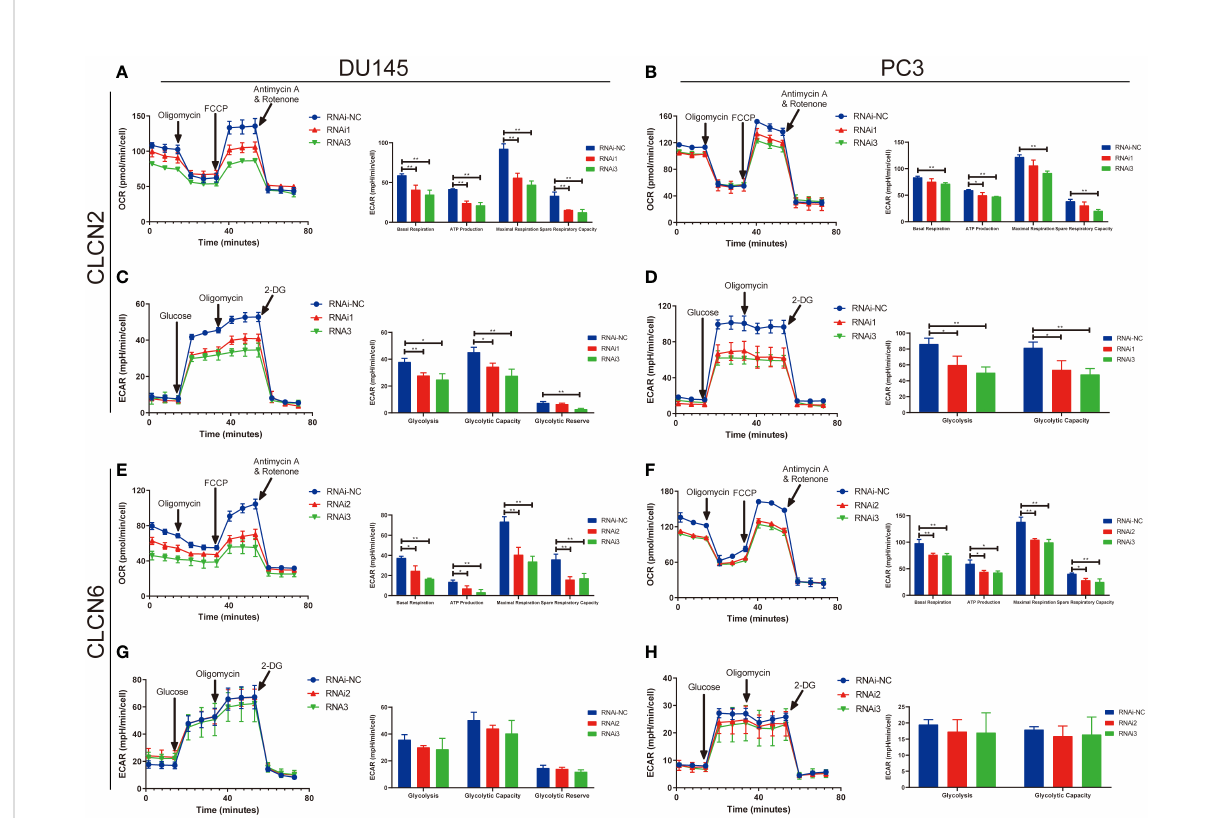
FIGURE 13 Downregulation of CLCN2 or CLCN6 exerted inhibitory effects on energy metabolism. Downregulation of (A, B) CLCN2 or (E, F) CLCN6 inhibited basal respiration, ATP production, maximal respiration, and spare respiratory capacity. Downregulation of (C, D) CLCN2 inhibited glycolysis, glycolytic capacity, and glycolytic reserve. (G, H) There was no signi fi cant difference when CLCN6 was downregulated. * p<0.05 and **